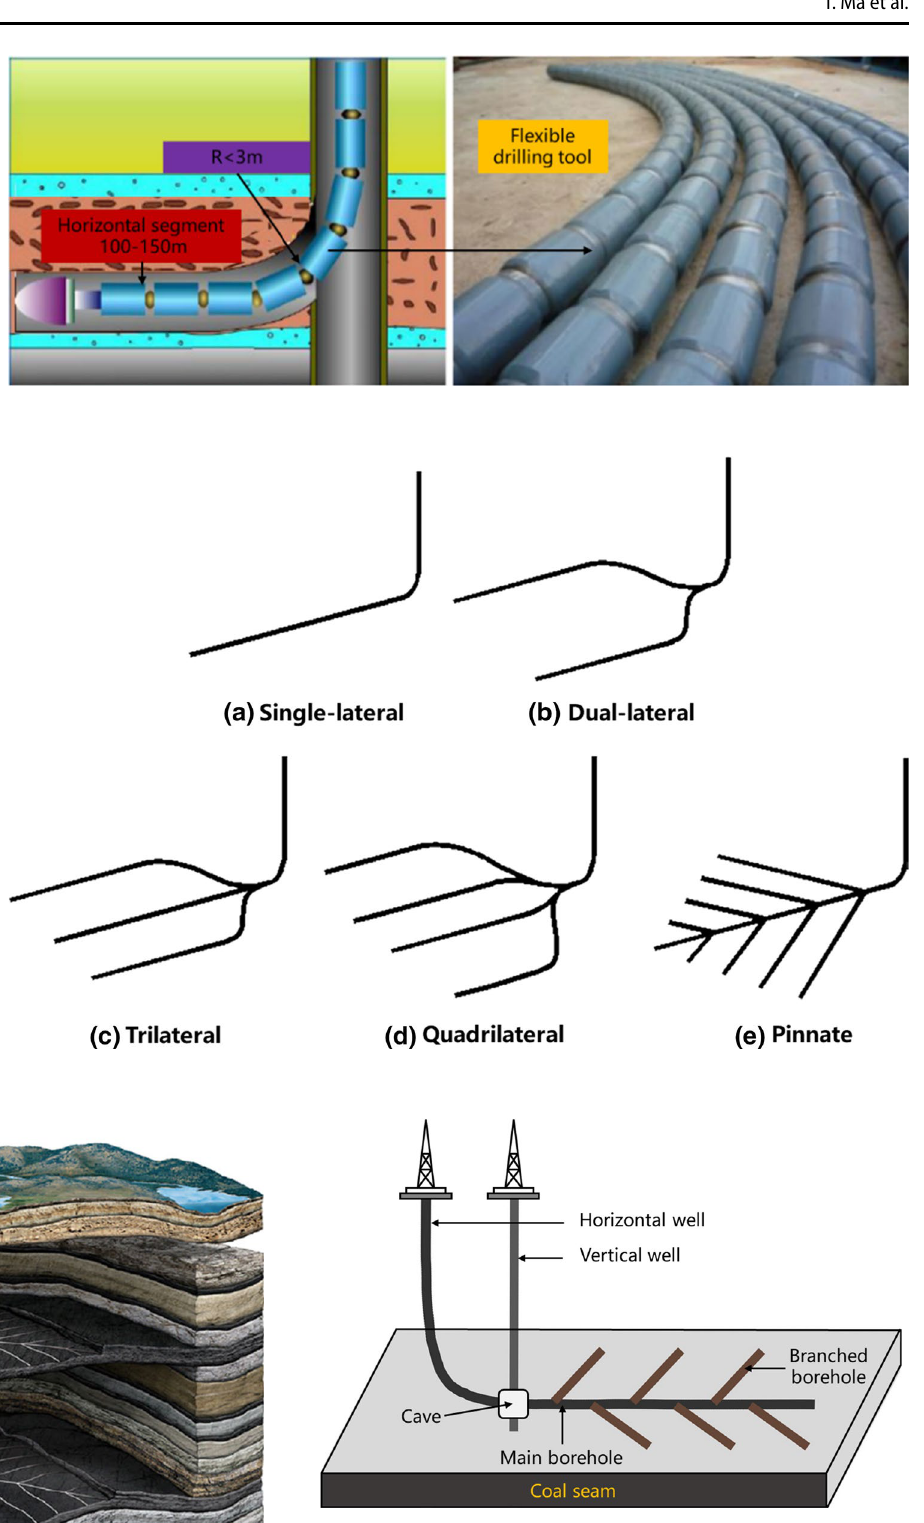
Fig. 13 Schematic of a single pinnate horizontal well, after Tao et al.